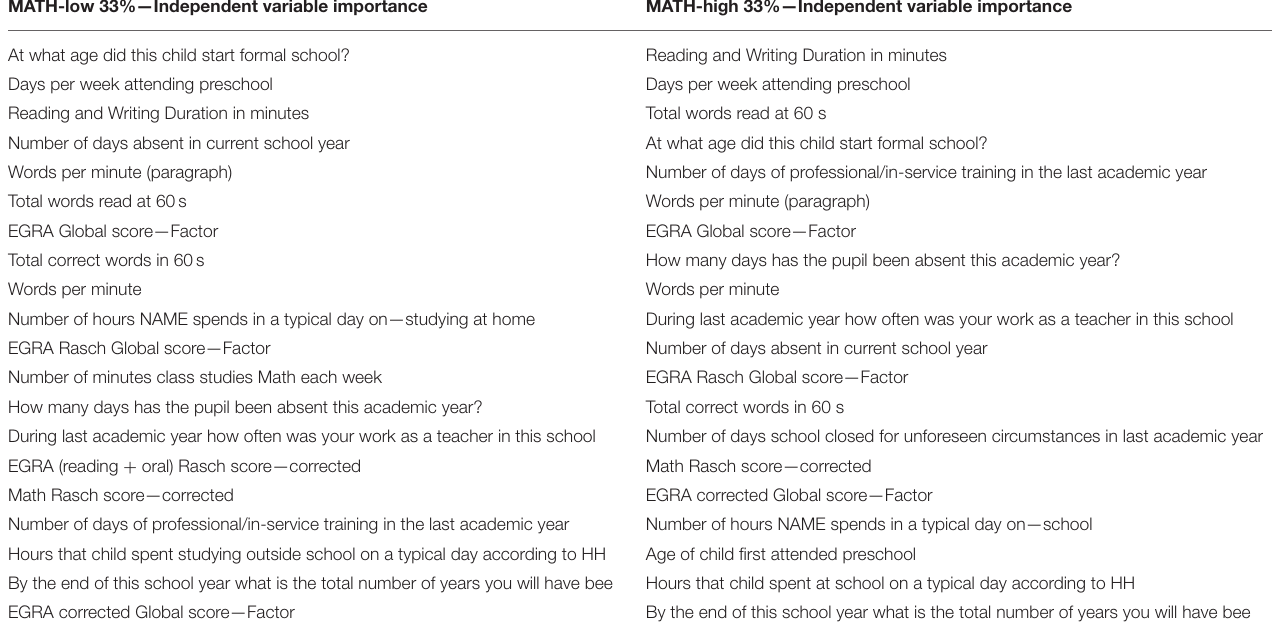
TABLE 5 | Top 20 variables by predictive weight for math performance